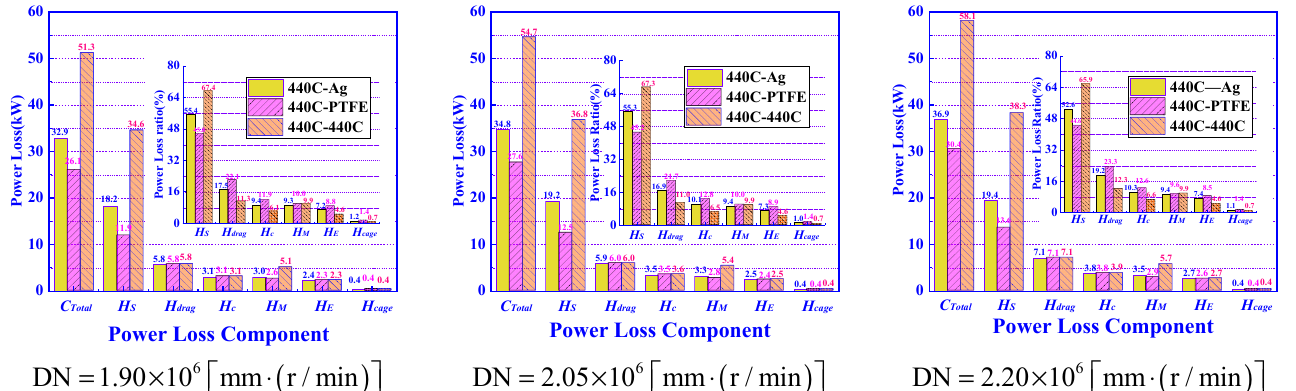
Figure 12. Power loss of the ball bearing under different DN values.